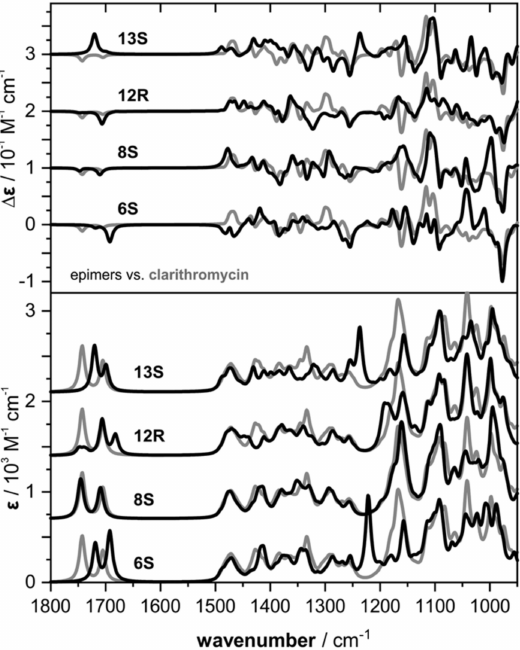
Figure 7. Comparison of the calculated IR and VCD spectra of the epimers 6 S -, 8 S -, 12 R - and 13 S - clarithromycin with the spectra computed for the actual configuration of clarithromycin (grey line), as depicted in Figure 5. Reprinted with permission from ref. [45]. Copyright 2020 Royal Society of